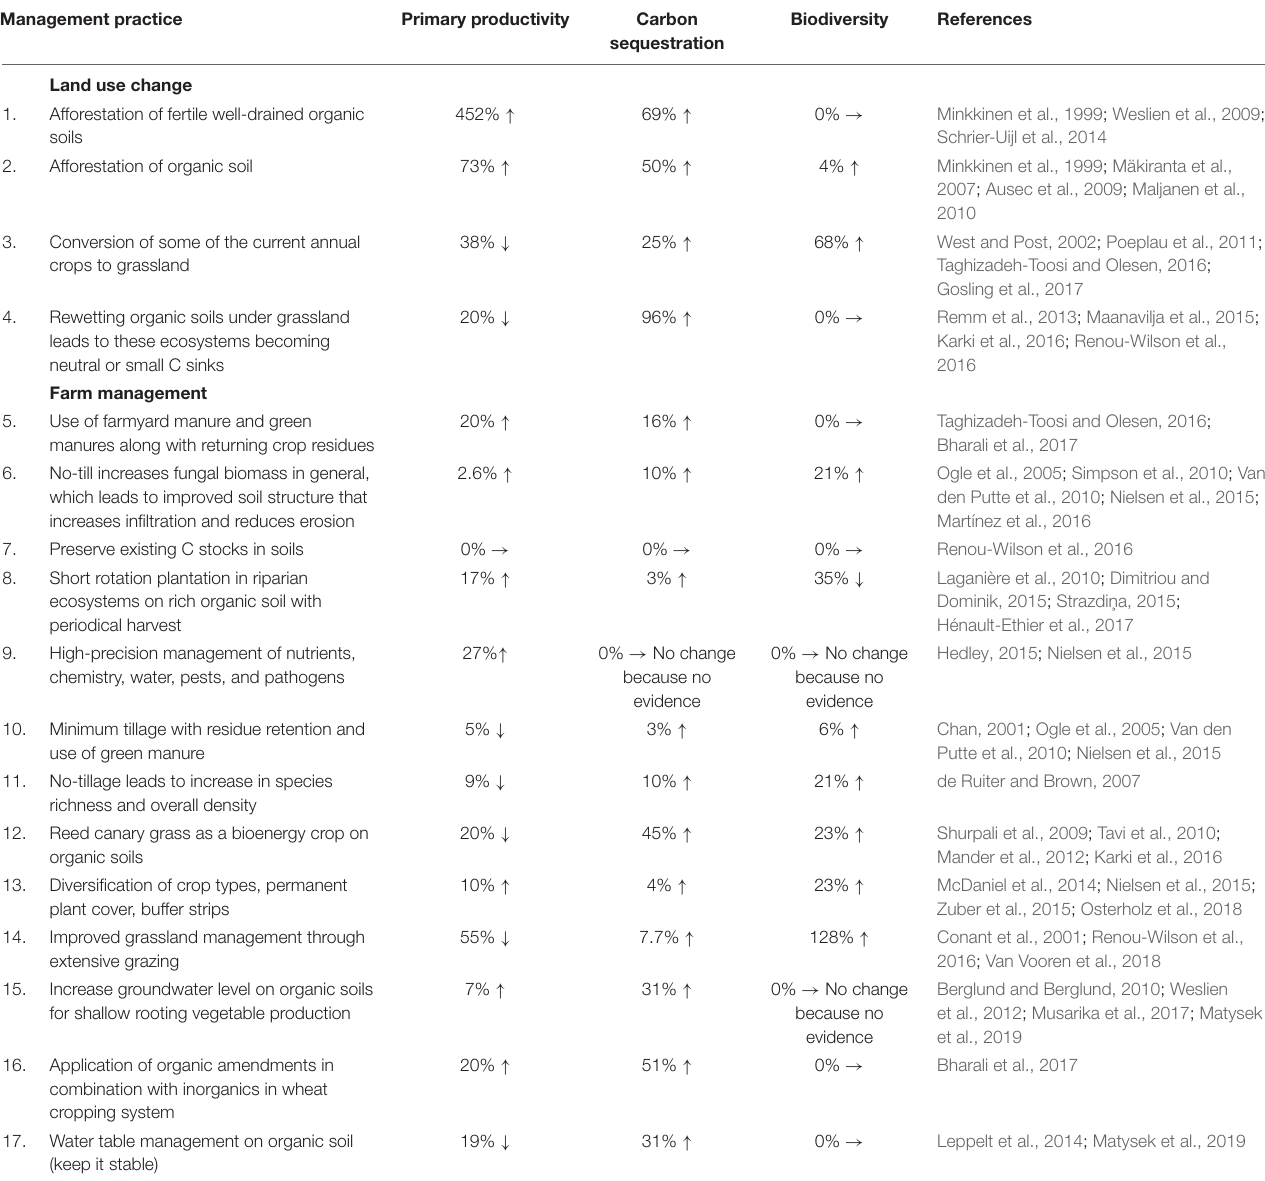
TABLE 1 | List of possible management practices ( ↑ –increase; ↓ –decrease; → –do not